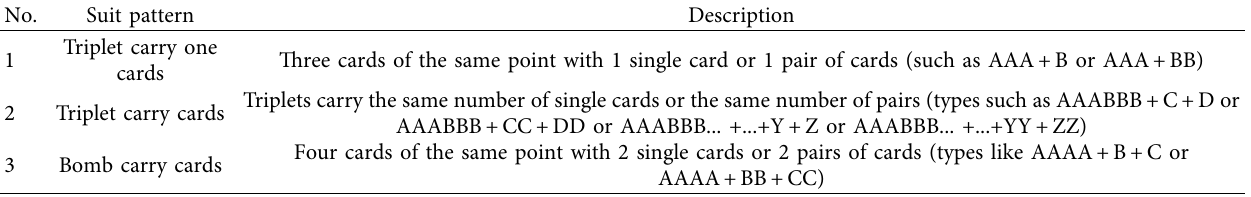
Table 2: Ways to carry cards.